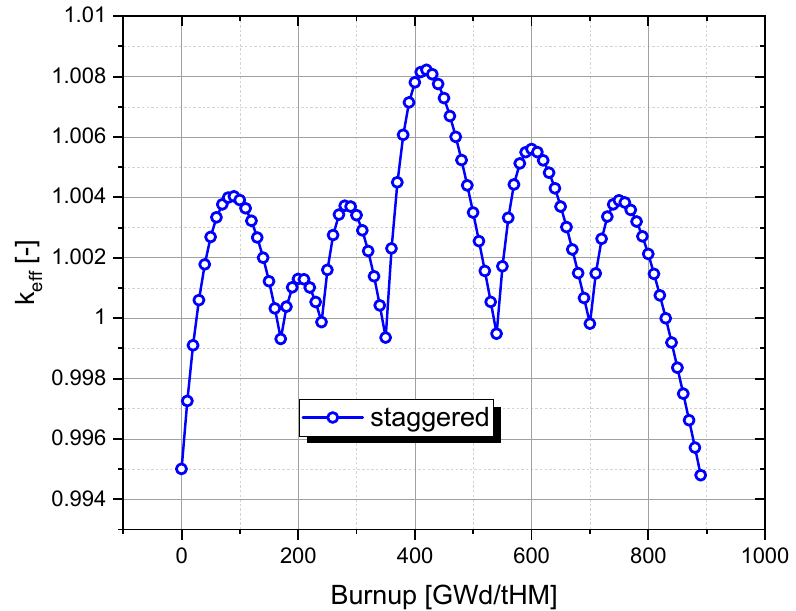
Figure 12. Development of the system criticality over burnup, considering the staggered separation of elements every time the system falls below criticality, based on a simulation using 10 GWd/tHM steps and a clean-up of 20% of the salt after each cycle.